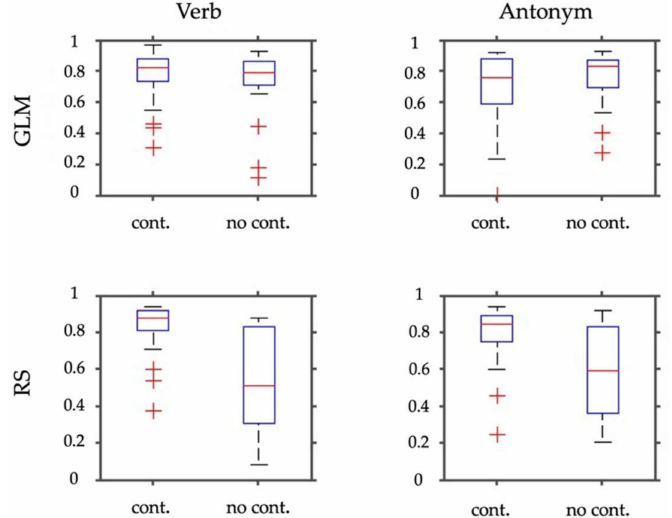
Figure 4. This figure depicts box plots of the WMLI of the laterality index calculations (absolute values). In the upper row, panels show results for the SPM contrasts (GLM) for the verb and antonym generation. The bottom row shows the same for the selected RS-fMRI components (RS). Each panel depicts box plots resulting from employing the task either with the control condition (cont.) or without (no cont.).